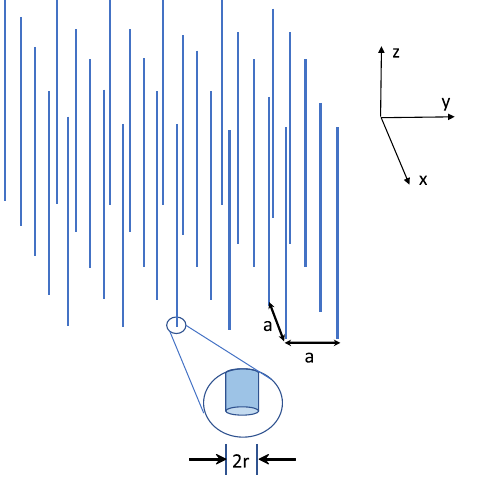
¼ wire ¼ 6 . 9 ps. t